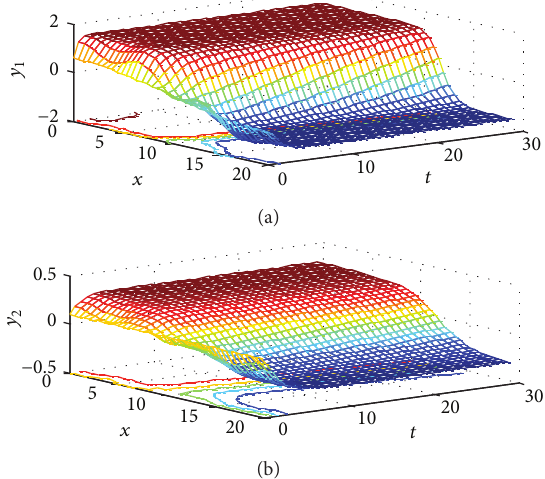
Figure 2: Open-loop profiles of evolution of 𝑦 1 (𝑥,𝑡) and 𝑦 2 (𝑥,𝑡)